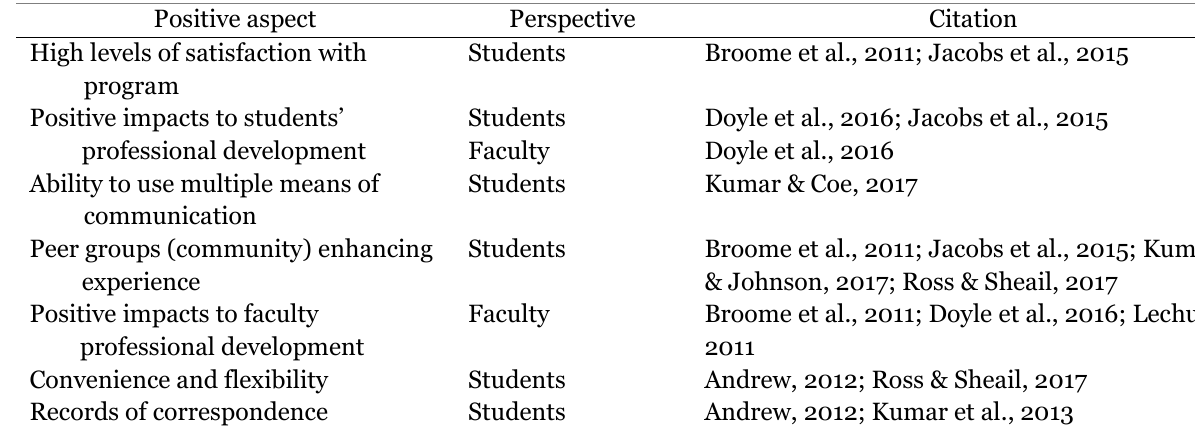
Positive Aspects of Online